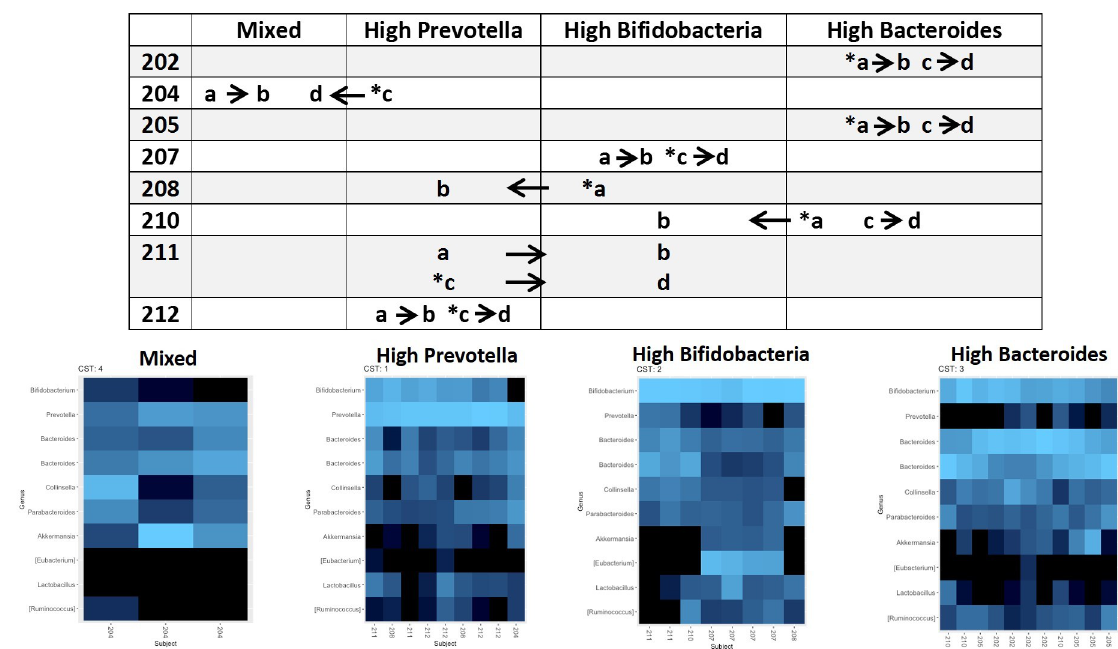
Fig 8. Microbial community state analysis. The bottom half of the figure shows four heatmaps corresponding to each of the four enterotypes identified in the study with the abundances of each bacterial taxon displayed by color (bright blue = more abundant; black = no/low abundance). The top half of the figure shows a chart indicating the enterotype of each participant during the various phases of the study. Arrows show the direction of transitions between enterotypes. The numbers (e.g. 204, 212) represent participant IDs to track transitions of individual participant microbiomes between enterotypes. The treatment period is indicated by a letter (a = pre BCP only treatment, b = post BCP only treatment, c = pre combination treatment, d = post combination treatment). The first arm that the participant was enrolled in is denoted by an